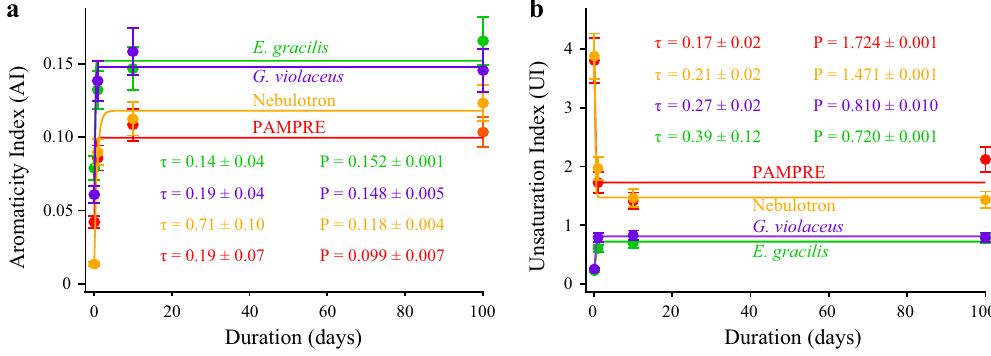
Figure 4. Evolution of XANES spectral parameters. AI ( a ) and UI ( b ) values of organic materials and the corresponding residues of 1, 10 and 100 day long advanced diagenesis experiments performed at 250 °C and 250 bars. Note that the evolutions of both AI and UI with experimental duration are well described by a first order kinetic law for the four organic materials (colored